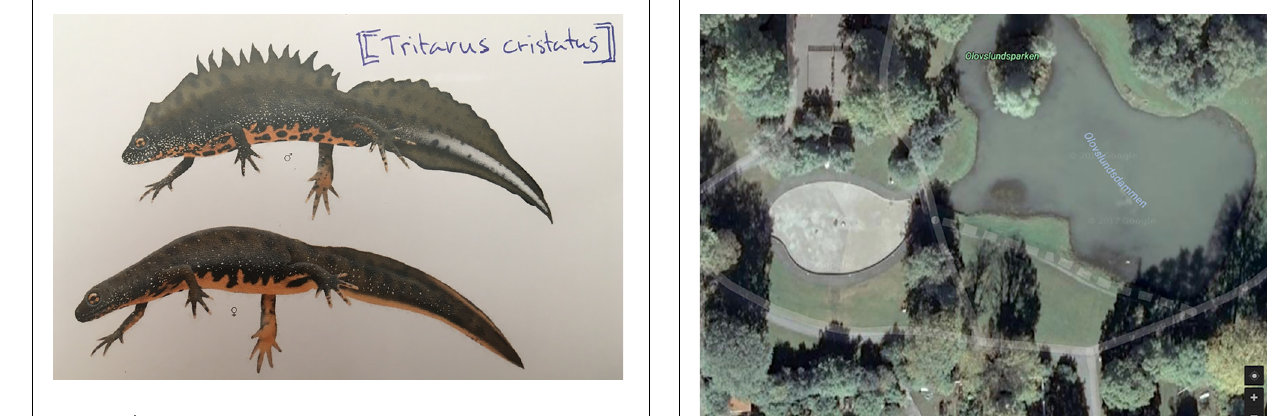
FIGURE 1 | The protected great crested newt ( Triturus cristatus ). Photo of postcard, Source: ArtDatabanken.